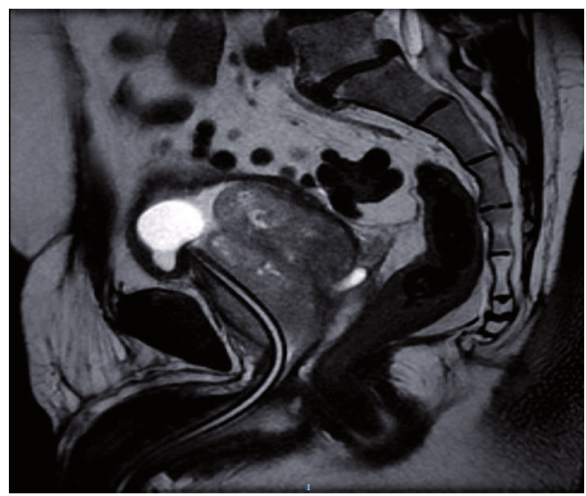
Figure 1 - T2-weighted prostate MRI in sagittal view showing a diffusely enlarged prostate. Note also the indwelling bladder catheter displaced anteriorly.